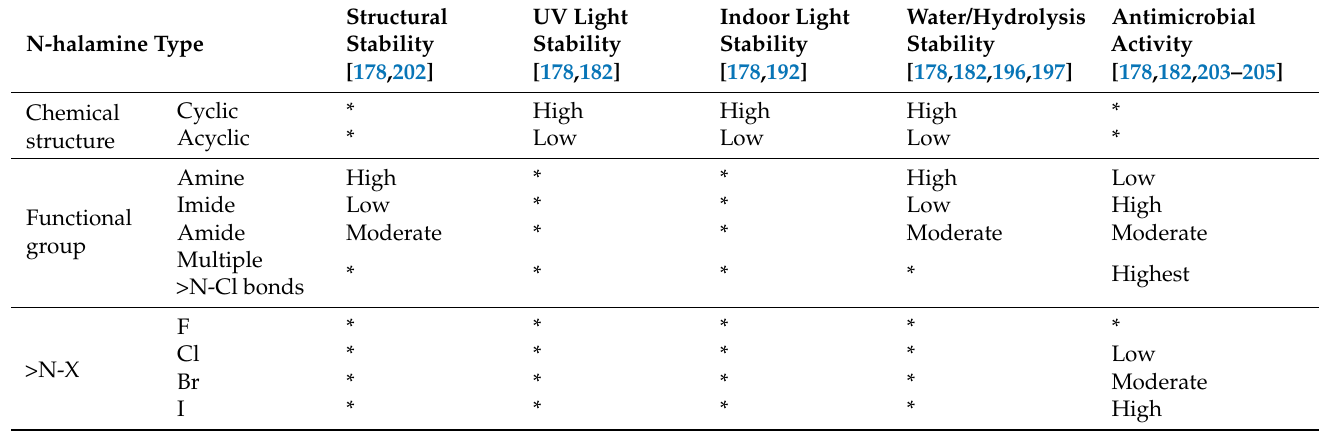
Table 2. Ranking the common N-halamine molecules based on stability and